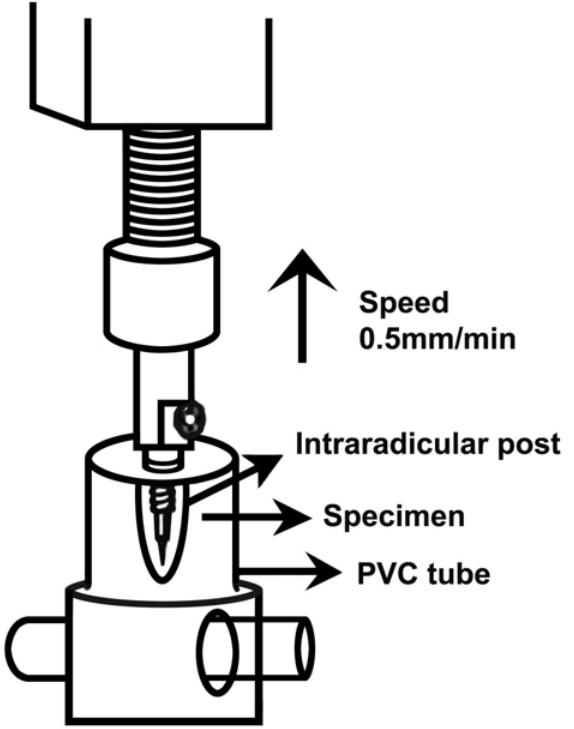
FIGURE 2- Schematic presentation of the pull-out test, showing the machine and the specimen